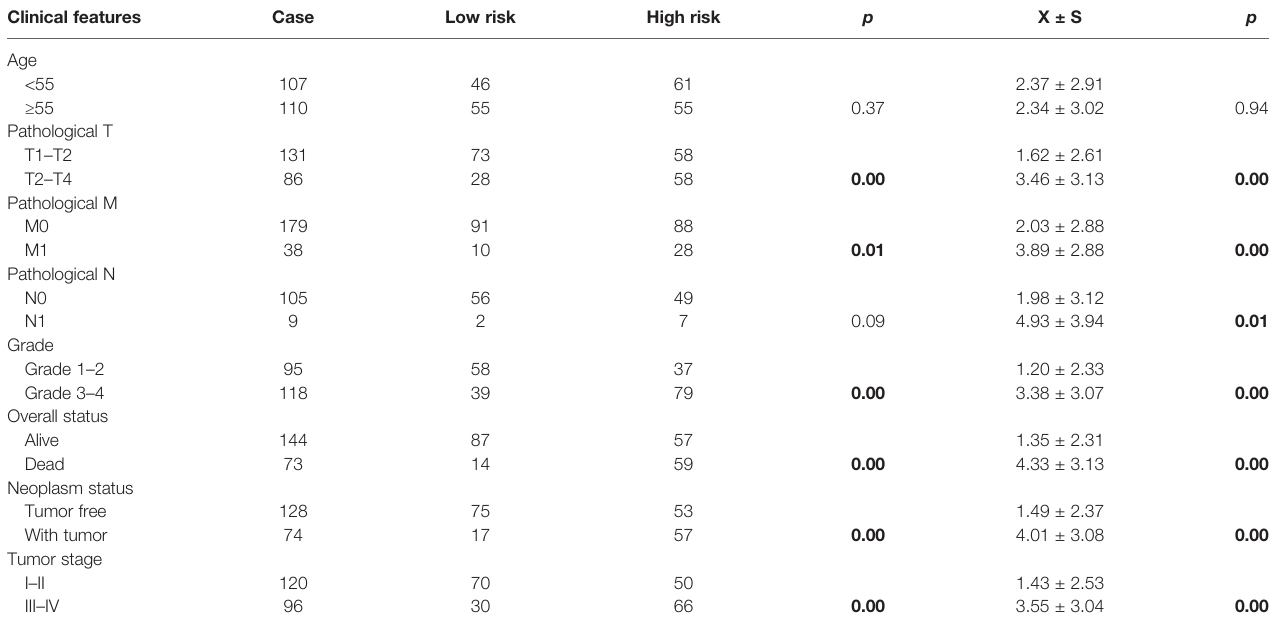
TABLE 2 | The analyses of correlation between risk scores and clinicopathological characteristics of patients in TCGA data set. Clinical